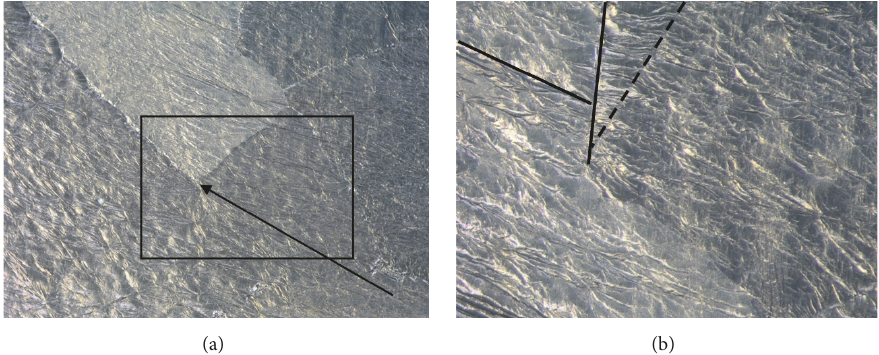
Figure 10: Optical micrographs of Pb 0.8/air sample: (a) magnification 5x and (b) magnification